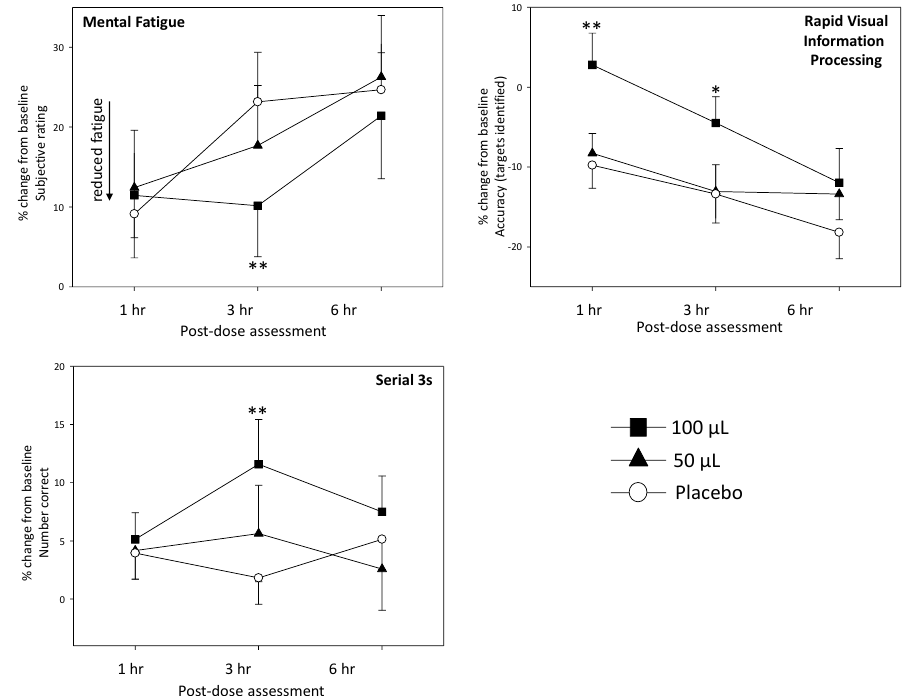
Figure 5. Effects of peppermint ( Mentha × piperita ) essential oil on the performance of the Cognitive Demand Battery tasks during the 1 h, 3 h and 6 h assessments. Data are mean (± SEM) % change from pre-dose baseline. Asterisks represent a significant difference to placebo from the a priori planned comparisons. *, p < 0.05; **, p < 0.01.